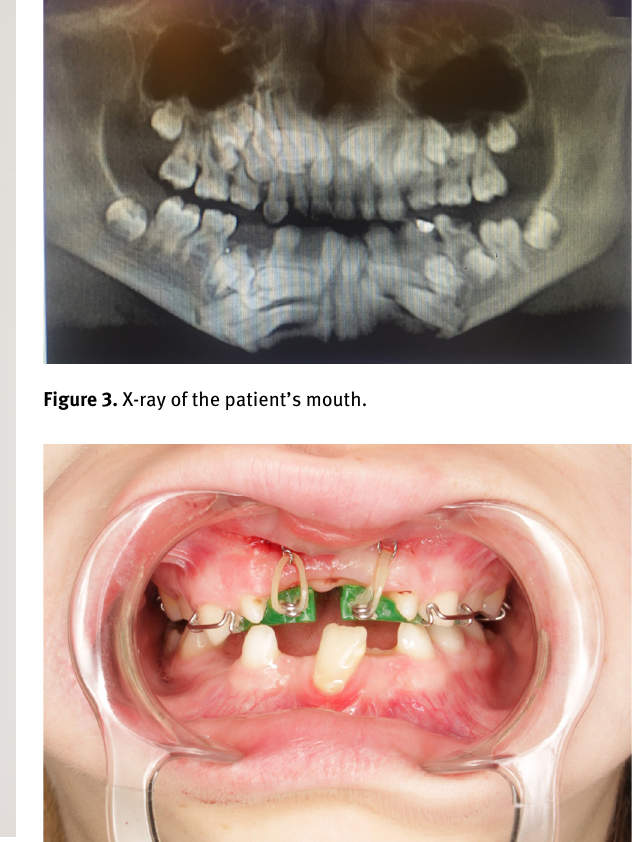
Figure 4. Close-up of the surgical treatment and corrective